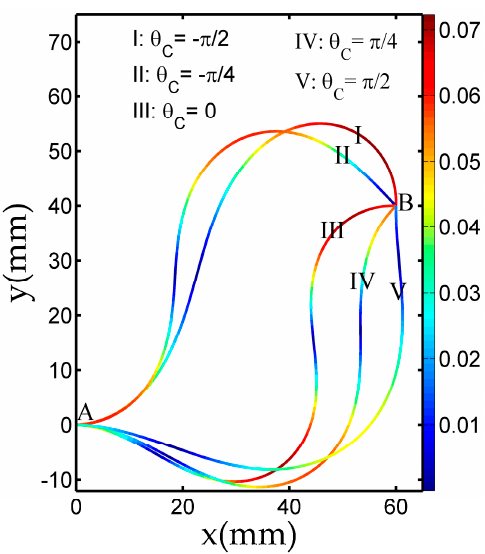
Figure 4. Optimized deformed shape of the two-point contact guidewire for different values of θ B .